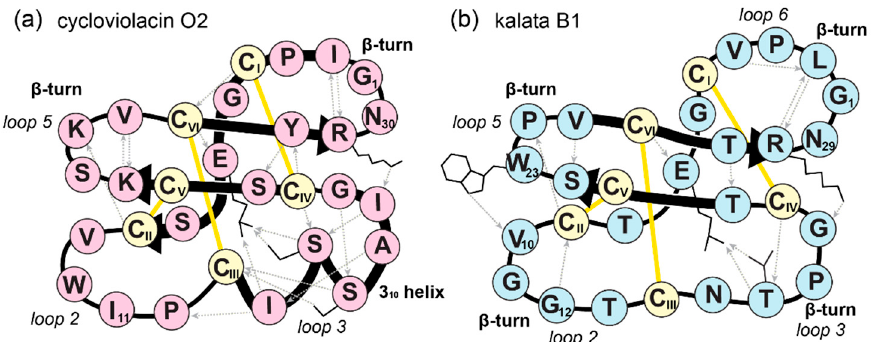
Figure 5. Comparison of the hydrogen bond network between cyO2 (this work, PDB ID: 7RMQ) and kB1 (PDB ID: 4TTM). Disulfide bonds are shown as yellow sticks. ( a ) Schematic representation of the structure and hydrogen bond network of cyO2. Secondary structures are highlighted as black arrows and ribbon. Hydrogen bonds are illustrated as gray dashed arrows. ( b ) Schematic representation of the structure and hydrogen bond network of kB1. Cysteine residues are labelled with Roman numerals in sequential order.